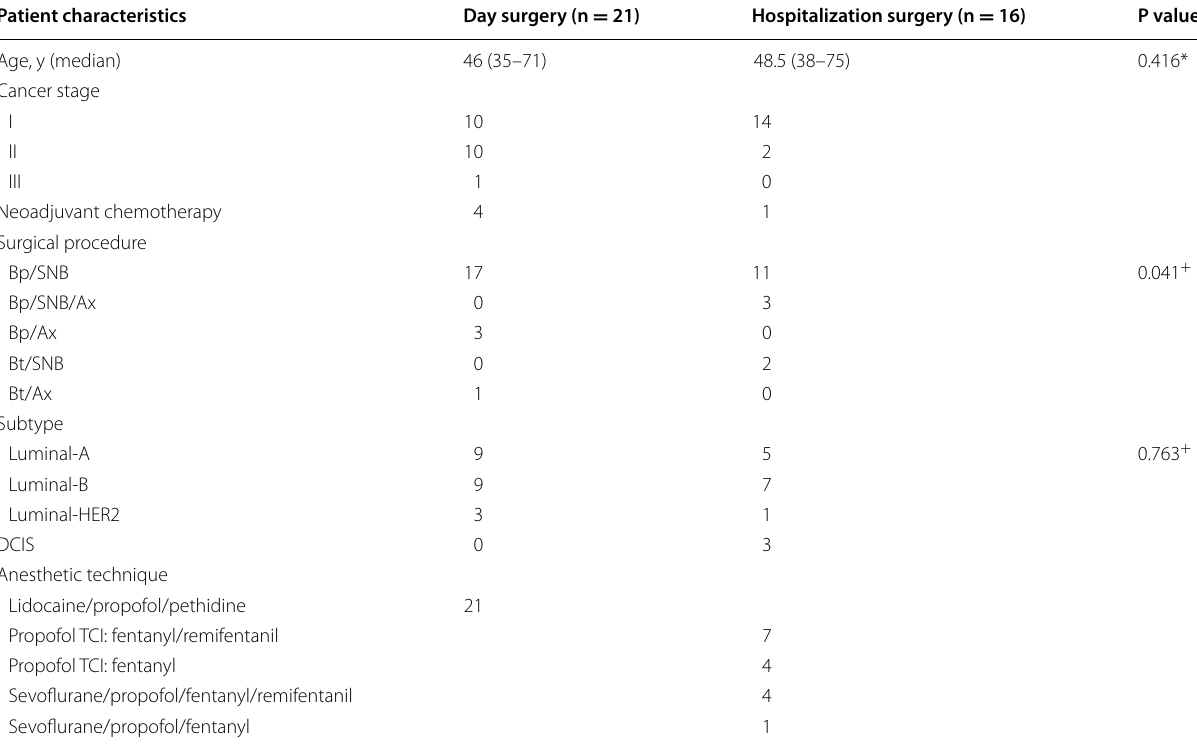
Table 1 Characteristics of the patient